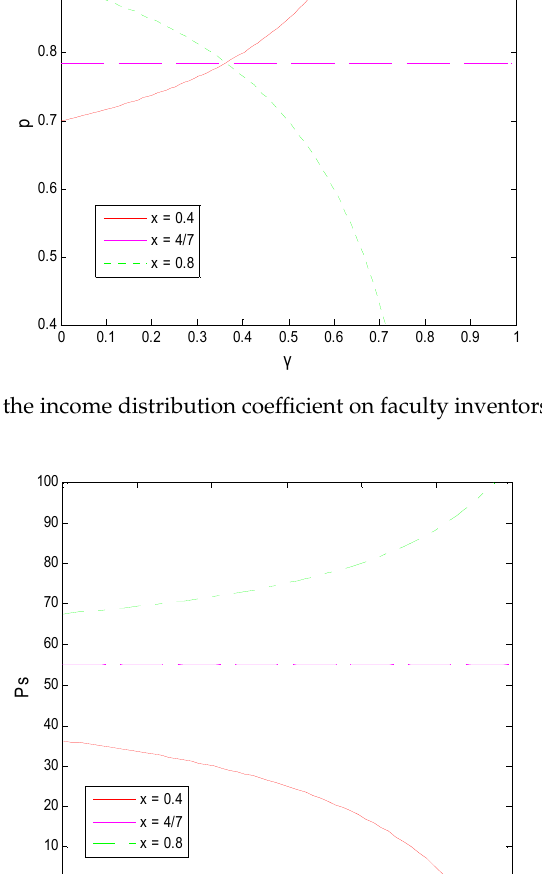
Figure 16. The e ff ect of the income distribution coe ffi cient on the technological transaction Figure 15. The effect of the income distribution Figure 16. The effect of the income coefficient on faculty inventors’ will to distribution coefficient on the “comply with rules”. technological transaction prices.